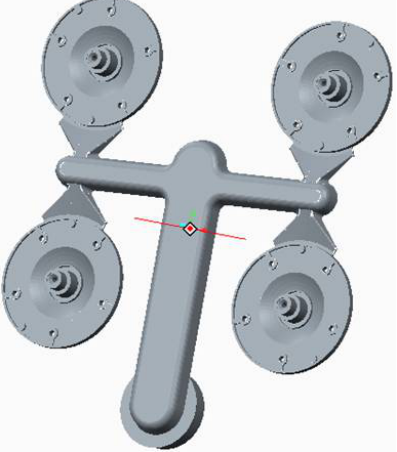
Figure 4. 3D model of designed gating system. Table 5. Dimension of the gating system.